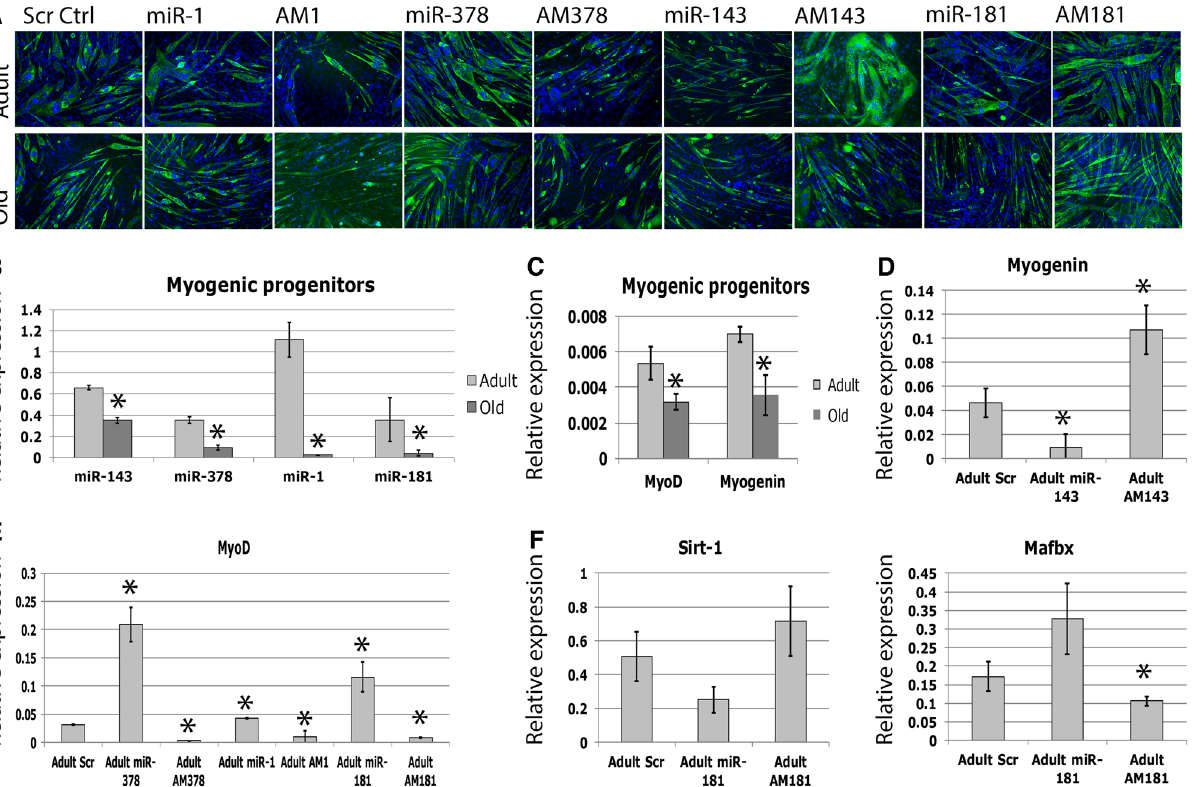
Figure 1. The role of selected miRNAs in regulating adult myogenesis. ( a ) MF20 immunostaining showing miRNA regulation of myogenic differentiation of primary myoblasts from adult or old mice. Green – MF20, blue – DAPI. ( b–g ) qPCR showing changes in miRNA and gene expression in murine myogenic progenitors during ageing or following microRNA overexpression (mimic, miR) or inhibition (antimiR, AM). Expression relative to Rnu-6 (miRNA) or β-2 microblobulin (mRNA) is shown, *p < 0.05 as compared to Adult/Adult scr; Error bars show SEM; n = 3. Adult – 6 months old, Old – 24 months old, Scr – antimiR